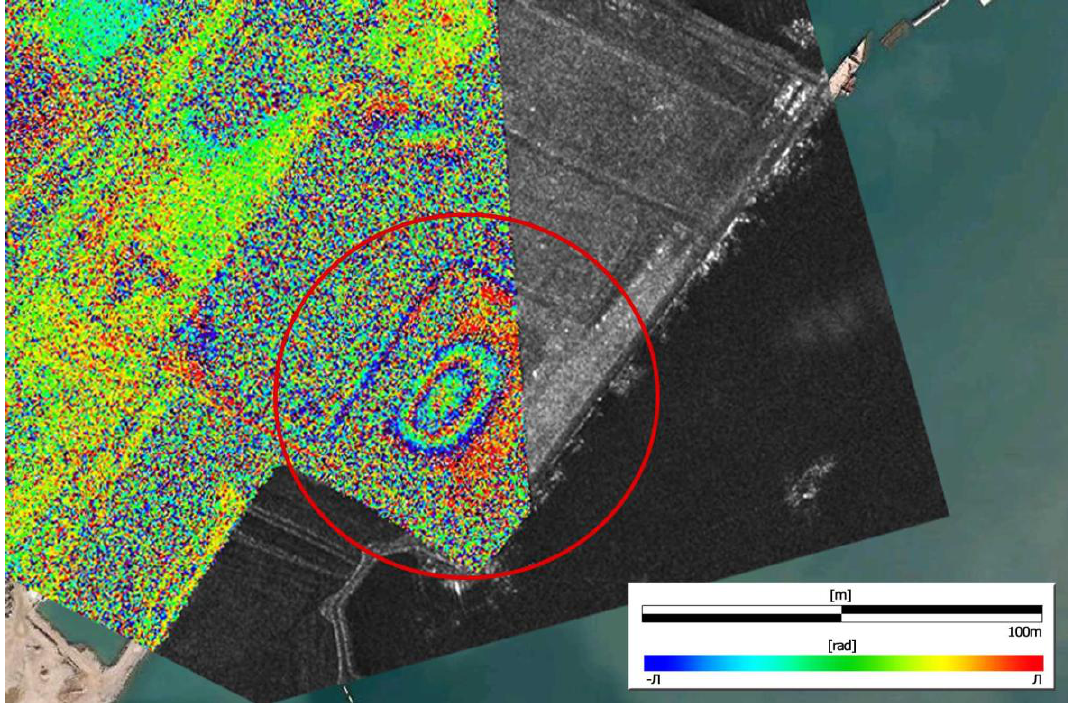
Figure 4. X-band interferometric phases from TerraSAR-X over the Port of Barcelona (Spain). The phases are superimposed over a SAR amplitude image, while a Google Earth image (© 2009 Google, GeoEye) is used as